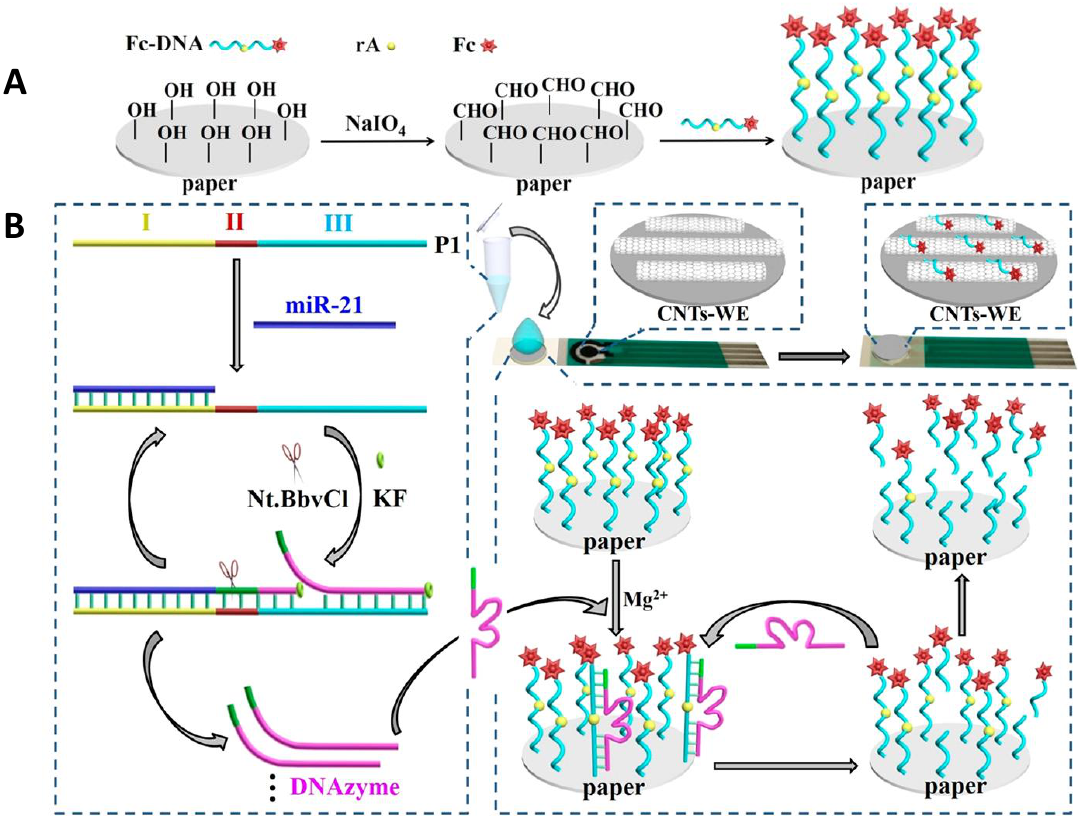
Figure 6. Schemes of ( A ) Ferrocene-labeled DNA (Fc-DNA) immobilization on paper and CNTs-SPEs, and ( B ) miRNA assay for the recognition of miR-21 (left), and the electrochemical response to the released DNAzymes (right). Reproduced and adapted with permission of American Chemical Society [38].